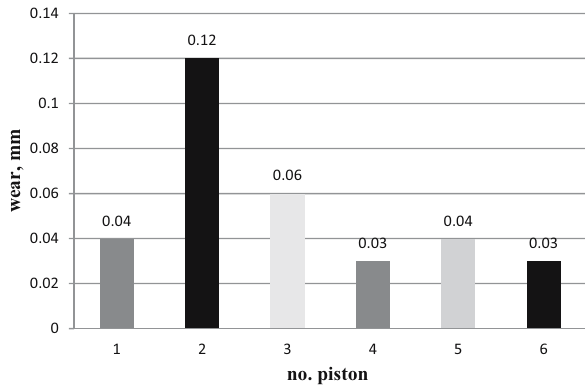
Figure 3: Average piston wear after 750